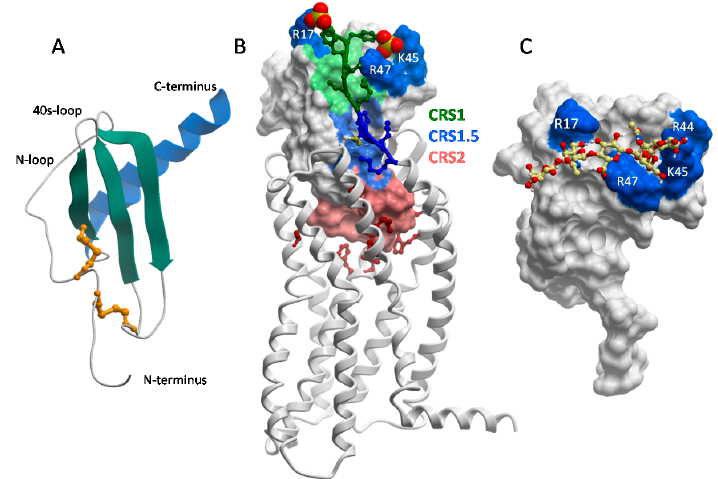
Figure 2. Chemokine tertiary structure, chemokine–receptor interactions, and chemokine– glycosaminoglycan interactions. ( A ) Structure of a typical chemokine, illustrated by a monomeric subunit of CXCL8 (PDB ID 1IL8 [48]). ( B ) Structure of CCR5 bound to a variant of CCL5 with a modified N-terminus (PDB ID 5UIW [52]). Chemokine recognition sites 1, 1.5 and 2 (CRS1, CRS1.5 and CRS2) are highlighted in green, blue and salmon. In CRS1, residues that contribute to GAG binding are highlighted in dark blue (R17 and 40s-loop BBXB motif residues R44 (not visible), K45 and R47). Tyrosine sulfates are highlighted as orange and yellow spheres interacting with the 40s-loop cluster and R17. ( C ) Model of CCL5 in complex with a chondroitin sulfate (CS) hexasaccharide from paramagnetic relaxation enhancement and intra- and intermolecular nuclear Overhauser effect constraints (supplementary data to [56]). GAG binding residues R17, R44, K45 and R47 are highlighted in dark blue. Comparison with ( B ) shows that GAG and receptor utilize similar epitopes on the chemokine core domain (CRS1) and sulfation is involved in both cases. Consequently, binding of GAGs and receptors to chemokines are generally mutually exclusive. Panels ( A – C ) are not to